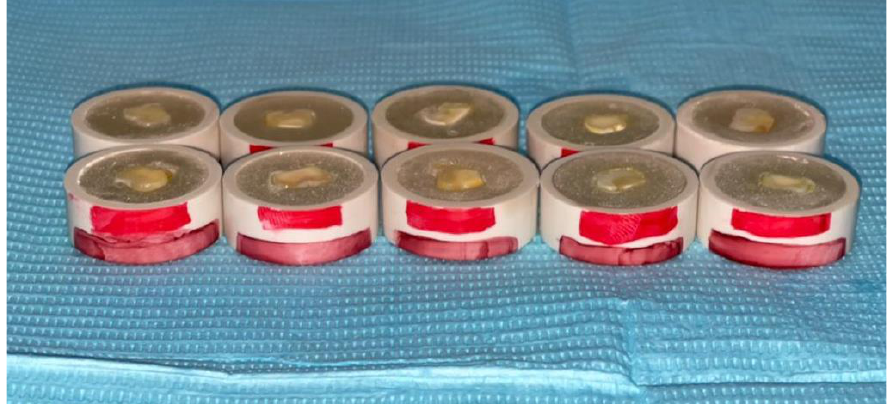
Figure 1. Teeth samples prepared for surface disinfection and bonding procedure.